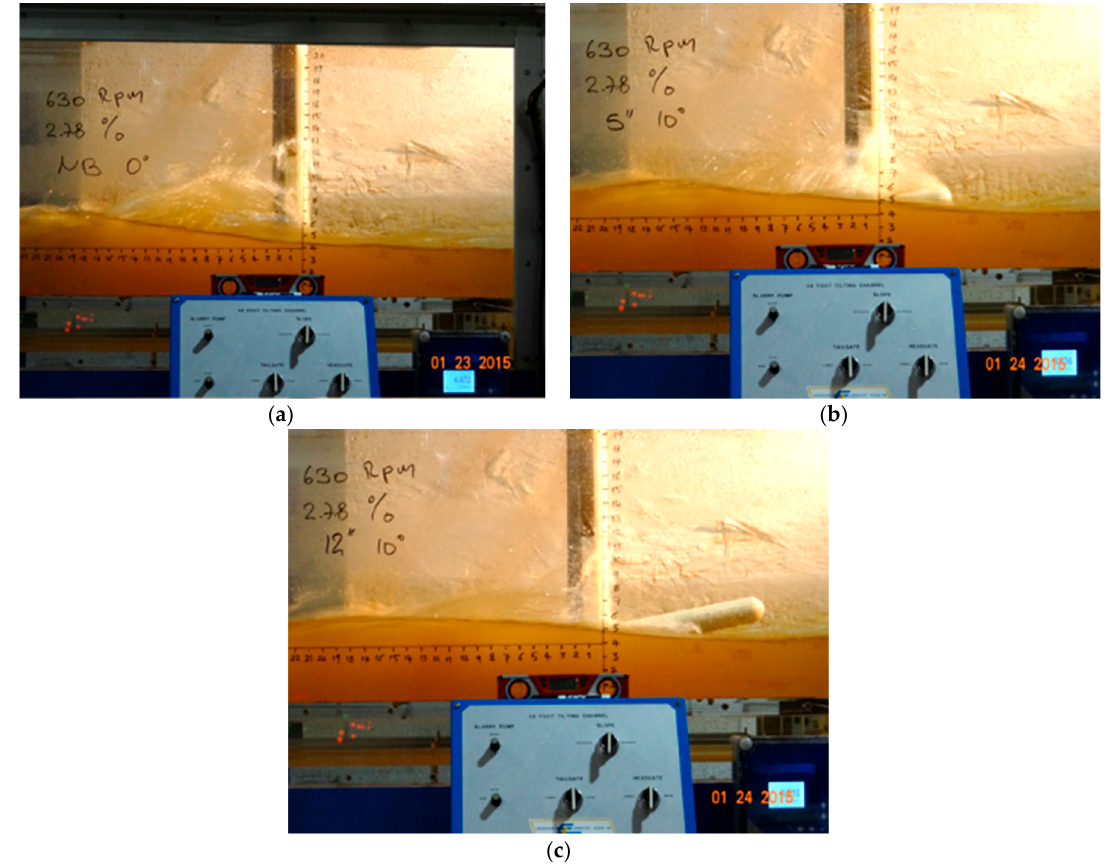
Figure 27. Water level after the pier-bulb intersection for ( a ) non-bulb pier, ( b ) bulbous pier with L bb = 5 ″ and at 10° pitch angle, and ( c ) bulbous pier with L bb = 12 ″ and at 10° pitch angle.